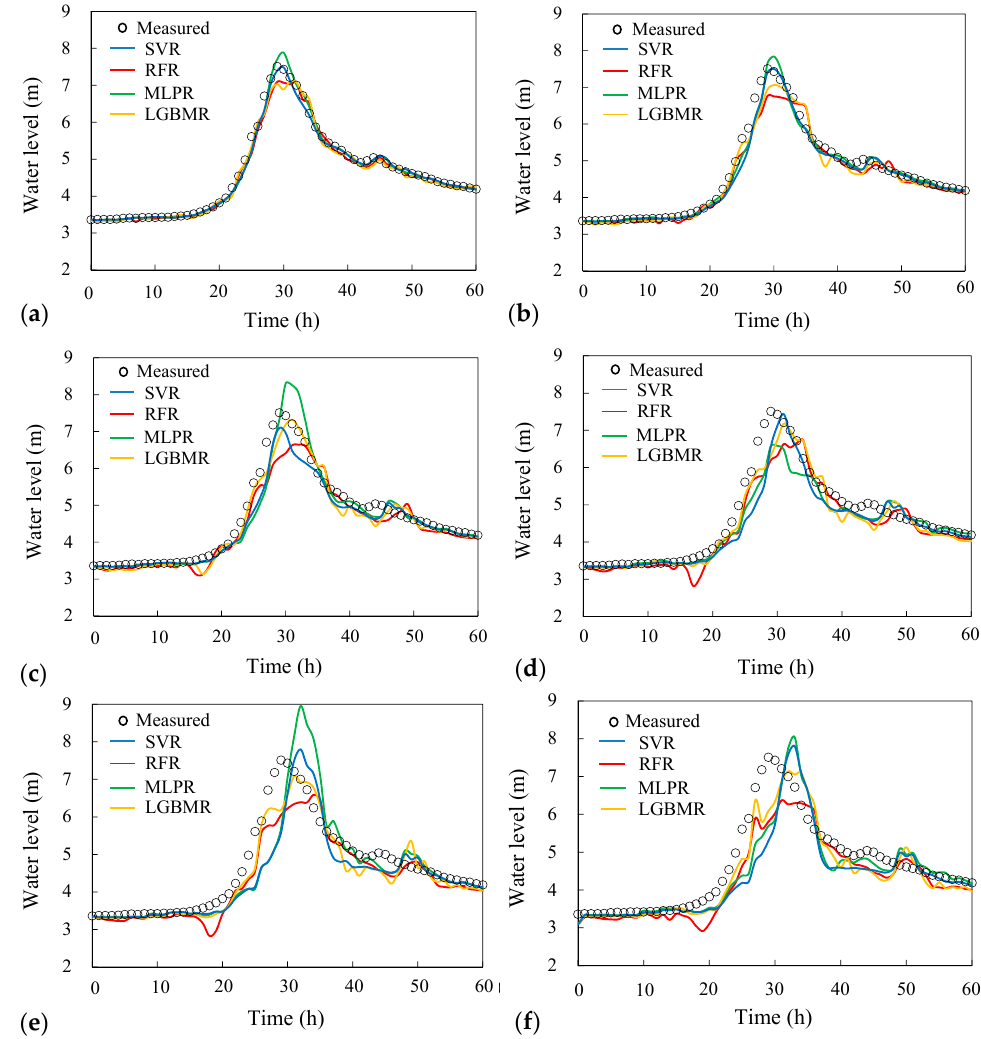
Figure 8. The comparison of measured and forecasted river stages at Lanyan station for Typhoon Megi with ( a ) 1-, ( b ) 2-, ( c ) 3-, ( d ) 4-, ( e ) 5-, and ( f ) 6-h lead times.